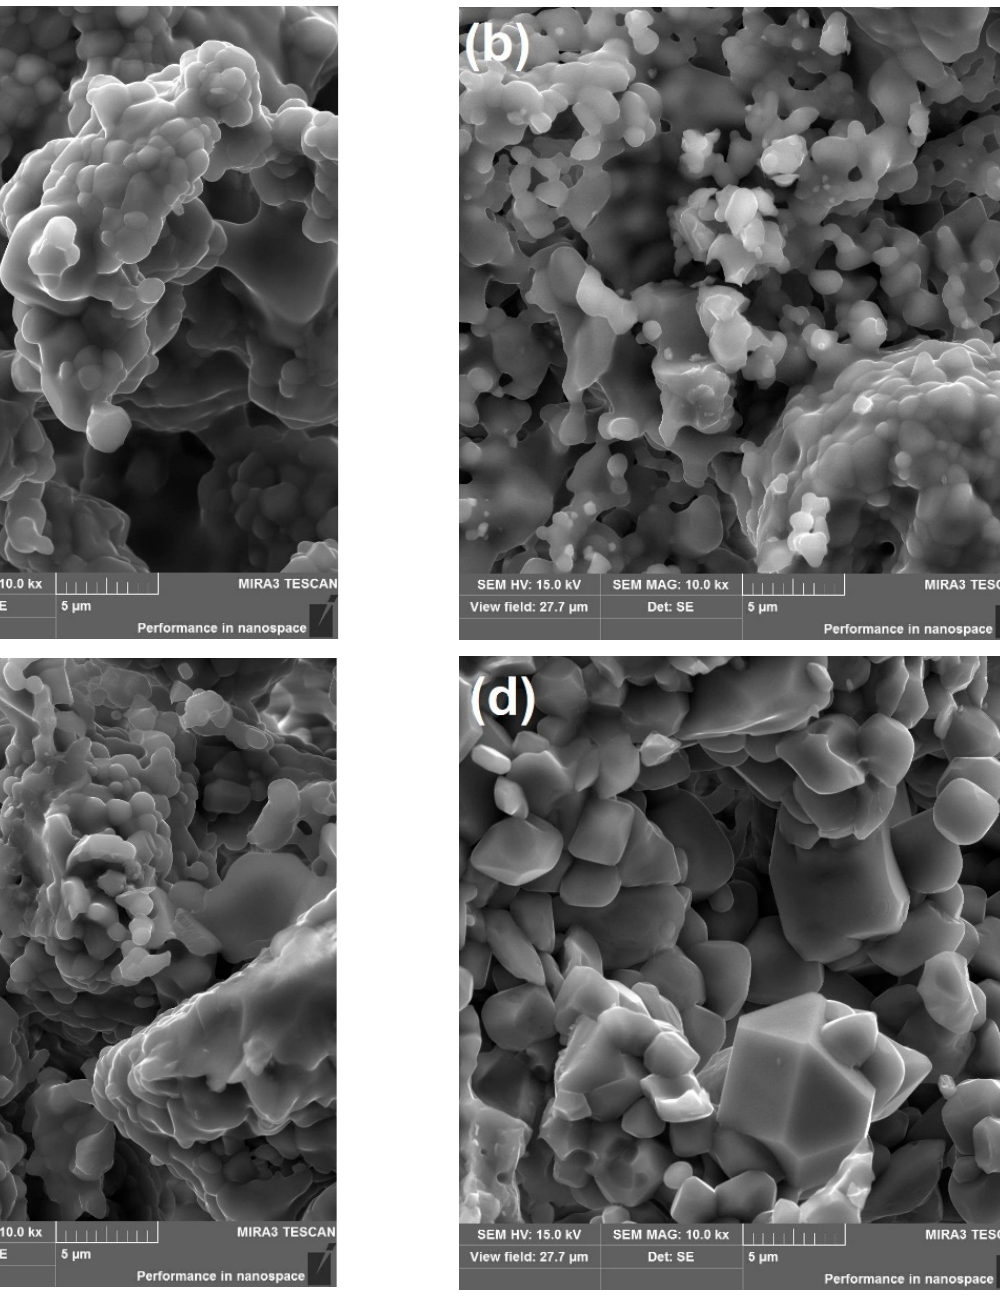
Figure 9. SEM images of the fracture of synthesized materials: A ( a ), C2 ( b ), E ( c ), and F ( d ). The synthesized materials were also subjected to investigations into the initial characteristics of the obtained binders and binding properties by preparing appropriate mineral slurries based on the obtained products of synthesis (Table 4).